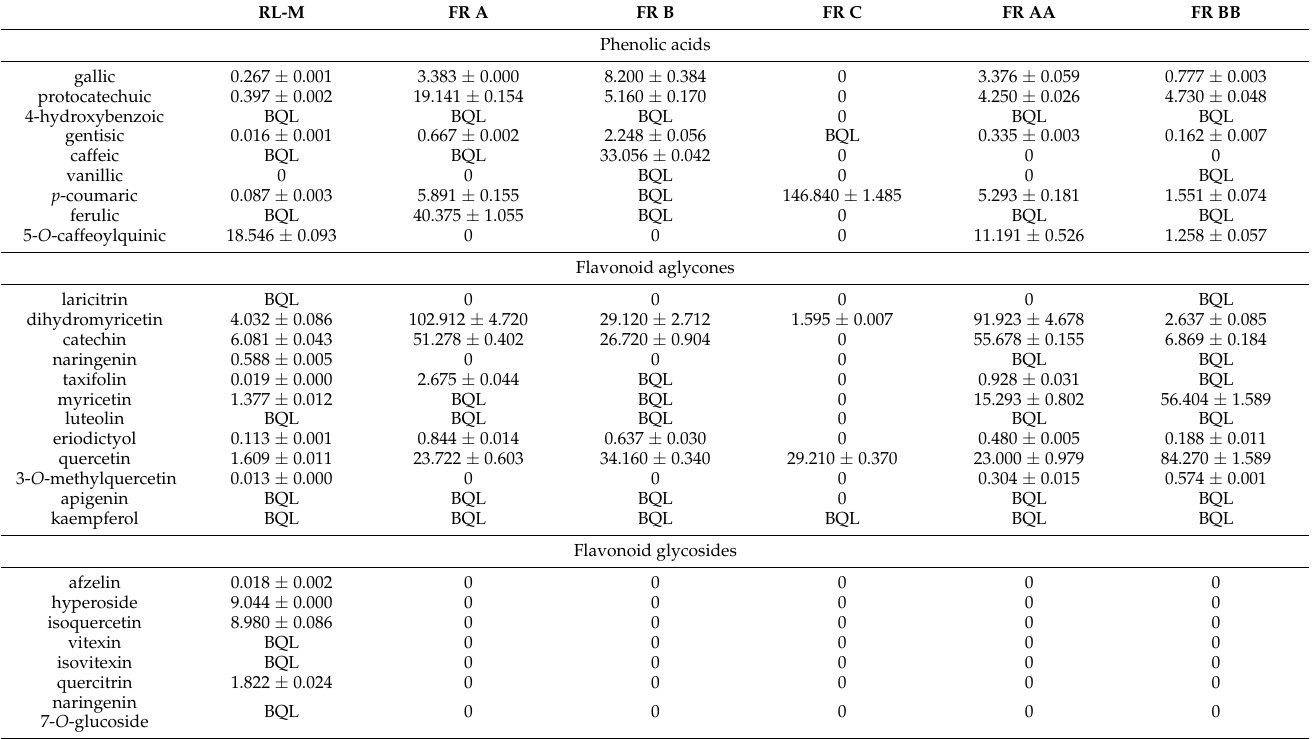
Table 1. Content of free and bound phenolic acids, flavonoid aglycones, and glycosides (mg/g of dry extract). Mean values of three replicated assays and standard deviations. Abbreviations: RL-M— methanolic extract, FR A—fraction of free phenolic acids, FR B—fraction of glycoside-bound phenolic acids, FR C—fraction of ester-linked phenolic acids, FR AA—fraction containing free phenolic acids and free flavonoid aglycones, FR BB—fraction containing glycoside-bound phenolic acids and flavonoid aglycones, BQL—compound detected, but its concentration was below the quantification limit. RL-M FR A FR B FR C FR AA FR BB Phenolic acids